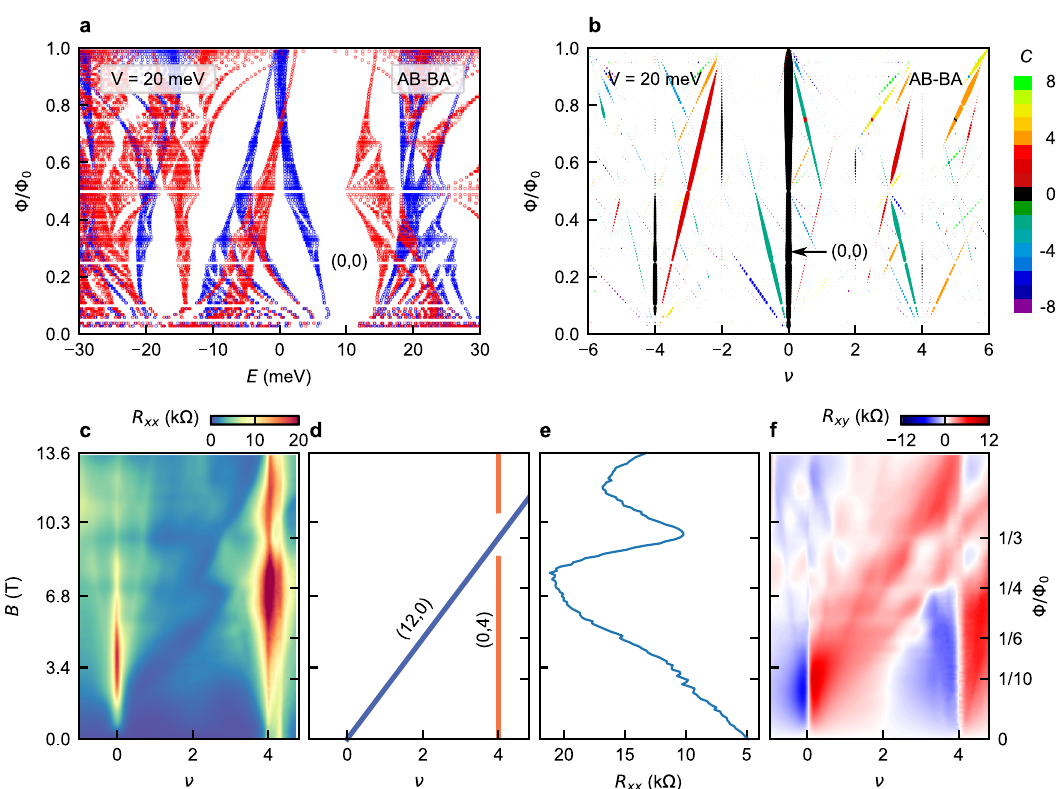
Fig. 4 | Role of topology on Hofstadter spectra. a Calculated Hofstadter energy moirégap(0,4)at Φ / Φ 0 =1/3whenaHofstadtergap(12,0)crosses. e Lineslicesof levelsforboth K (red)and K 0 (blue)valleysinAB-BATDBGwithtwistangle 1.10 ∘ for R xx vs. B at ν =4 showing a clear dip at the crossing. f Color-scale plot of R xy corresponding to c . The Hofstadter gap (12,0) (with fi nite R xy ) dominates over the an interlayer potential of V =20 meV. b Evolution of gaps corresponding to the moiré gap (0,4) (zero R xy ),indicating thatHofstadter spectraacross the moiré gap spectrum in a .Unlike AB-ABcase (see Fig.3a,b),the CNPgap(0,0)isopen for any fl ux0< Φ / Φ ν and B at D / ϵ − 0.02V/nm are connected to each 0 <1. c Color-scaleplotof R xx asafunction 0 = from the 1.10 ∘ AB-ABTDBG device. d Schematicof c , showing the weakening of the